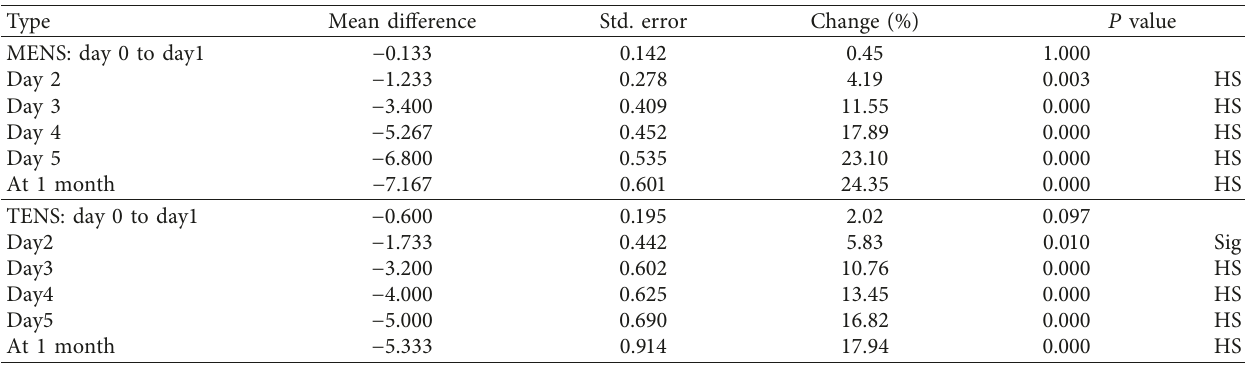
Table 3: Improvement in mouth opening in the study period between the TENS and MENS group (post hoc analysis by Bonferroni test; measure: MEASURE_1; parameter: MOUTH OPENING (MM)).